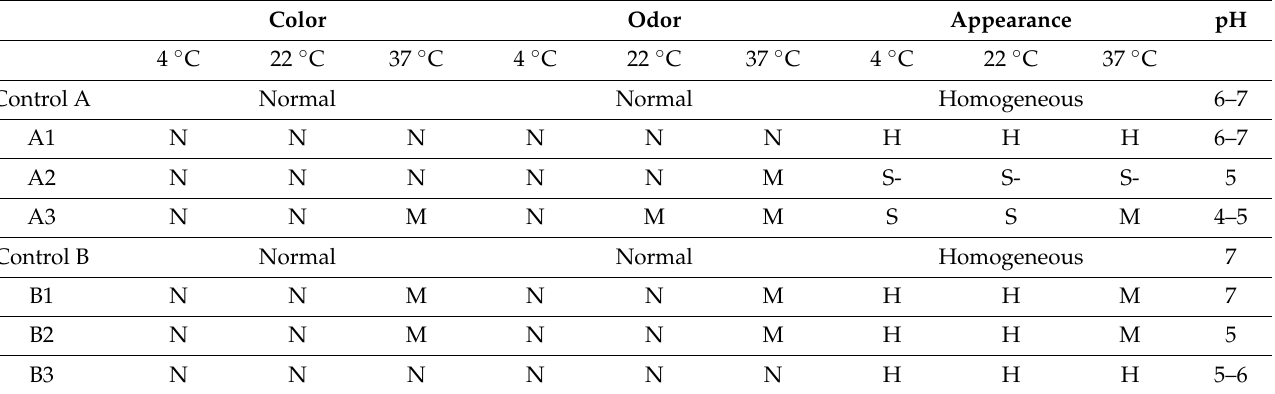
Table 6. Organoleptic properties of the formulations containing the cork extracts after 90 days of storage at different temperatures: 4, 22 and 37 ◦ C. H: homogeneous solution; S-: some surface separation (a small amount of transparent liquid forms on the surface); S: evident phase separation; N: normal, similar to the control; M: total modification of samples compared to control. Control: creams without addition of extracts; A1, B1: creams with extracts obtained with lactic